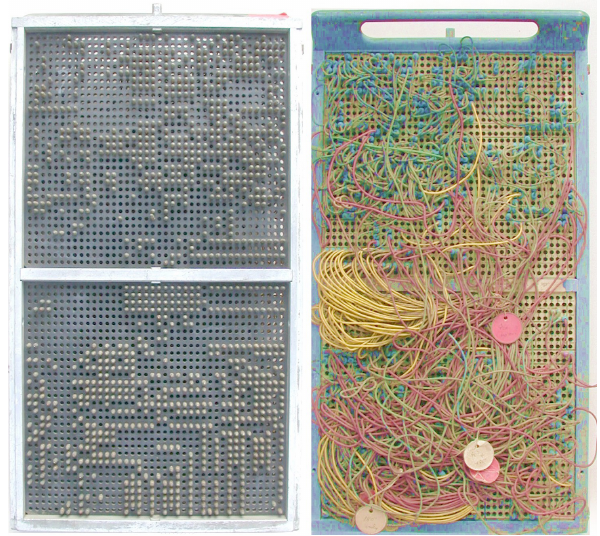
Figure 16. Plugboard for programming the digital correlator used at Jicamarca in the early 1960s. The plugboard had 2 × 1024 holes, and some of the programs required the use and connection of every